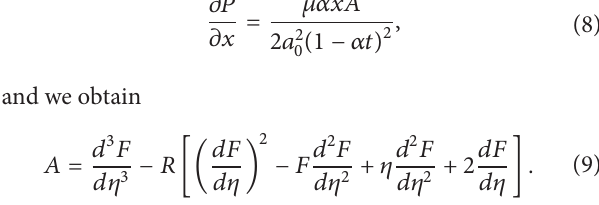
Figure 1: Schematic diagram of the problem.